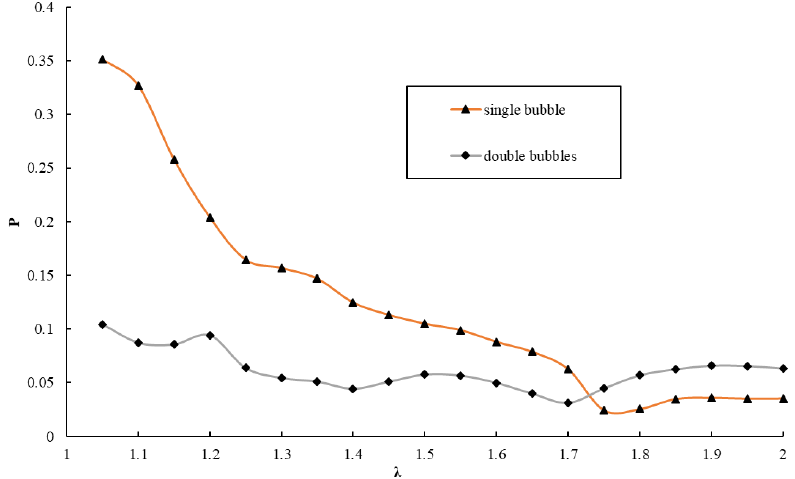
Figure 11. Comparison of the maximum wall pressure under different initial conditions.